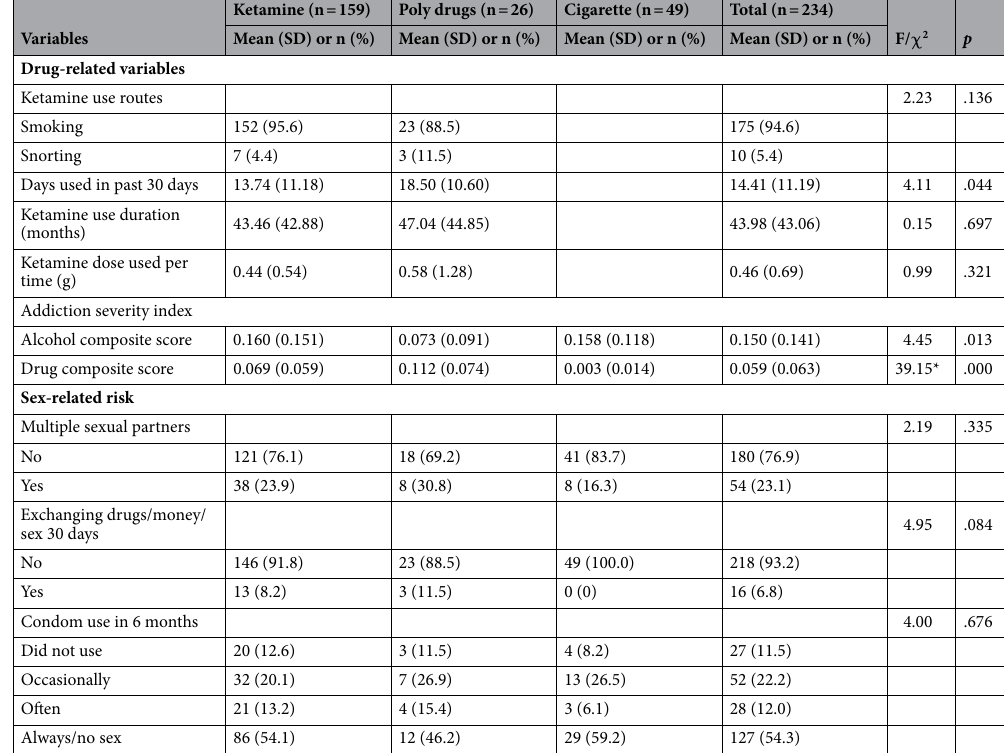
Table 2. Drug use and sex risk behavior amongst participants. Bonferroni correction was used to adjust multiple comparisons. Tukey’s method was performed to test the post-hoc difference. * p < .05/9 = .0056.